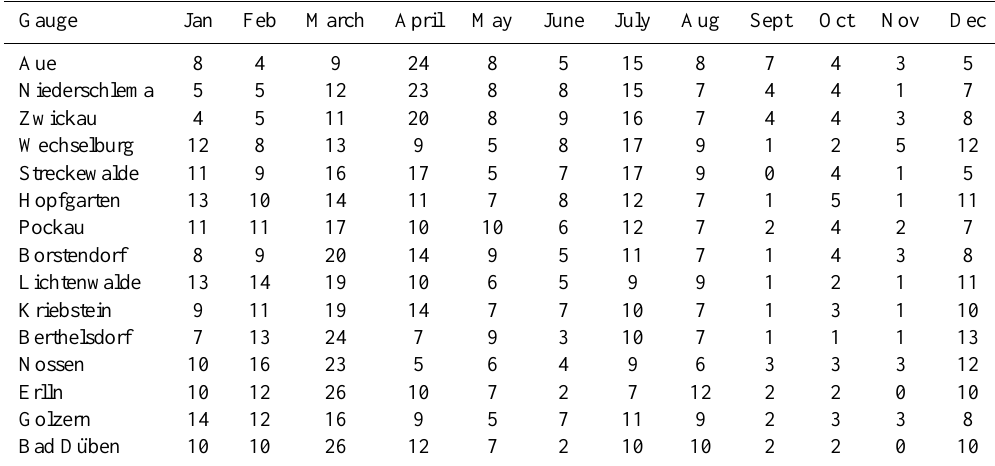
Table 3. Monthly relative frequency of discharge AMS (in percent).